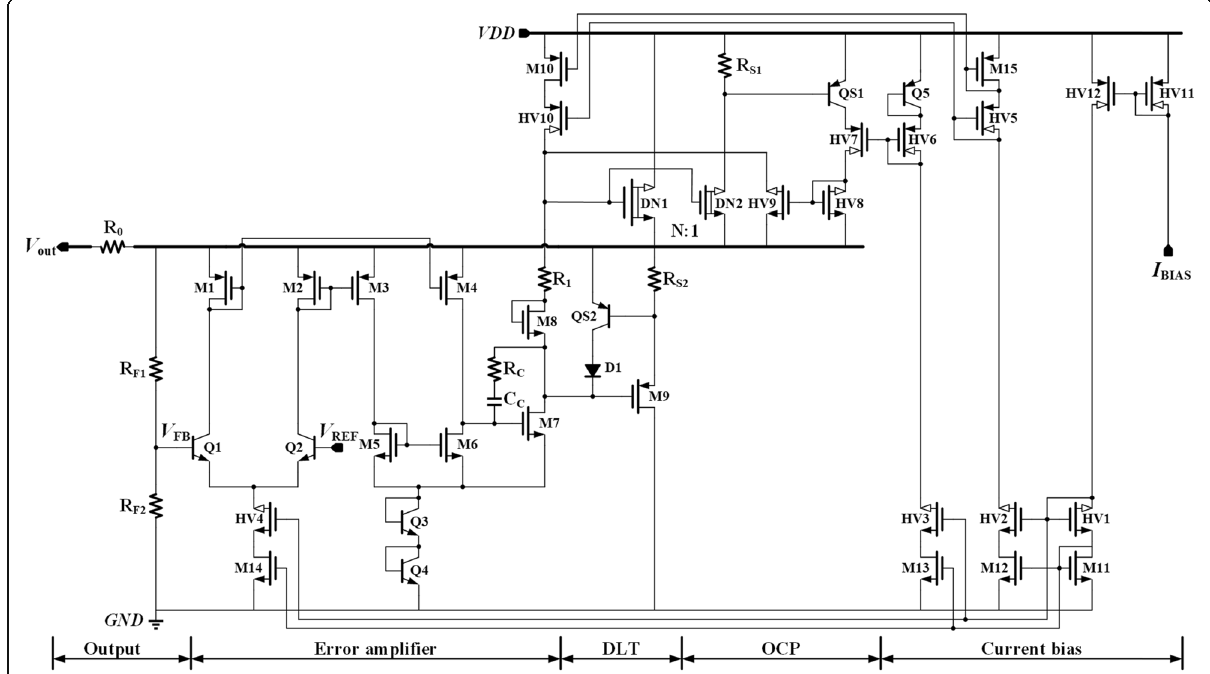
Fig. 1 The detailed circuit of the proposed